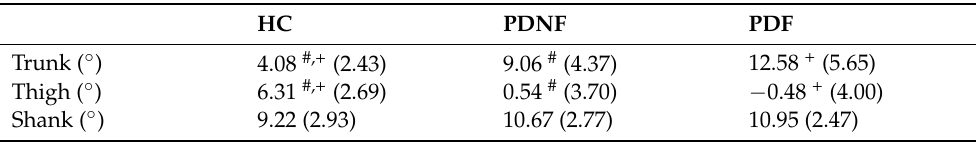
Table 4. Postural angles were computed shortly before the gait initiation execution (during a 1 s window before the onset of the anticipatory postural adjustments). Data are shown as mean (standard deviation). Abbreviations: HC, healthy controls; PDF, Parkinson’s disease with freezing of gait; PDNF, Parkinson’s disease with no freezing of gait.